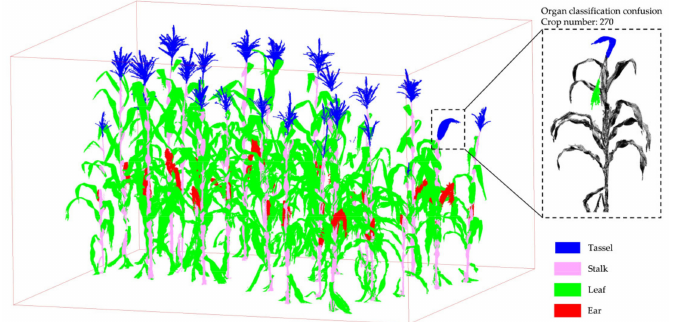
Figure 15. Maize-04 -No. 2 visualization. The blue point cloud is the topmost leaf that was mistakenly identified as the tassel, and the green is the naturally broken